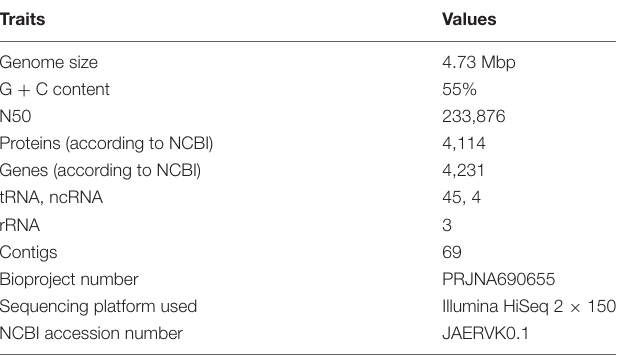
TABLE 3 | Genomic features of Methylomicrobium